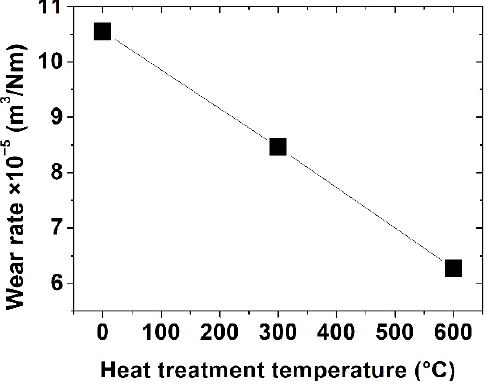
Figure 7. Effect of the heat treatment temperatures on the wear rate of the Ni-W/B composite coat- ings.